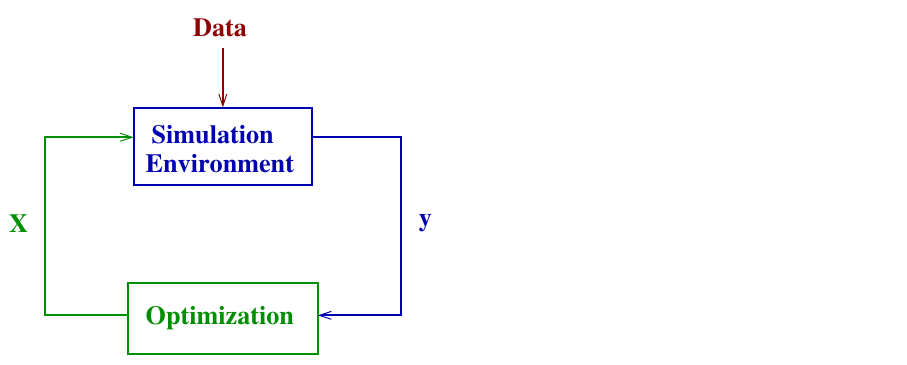
Figure 3. Objective-function evaluation based on a simulation